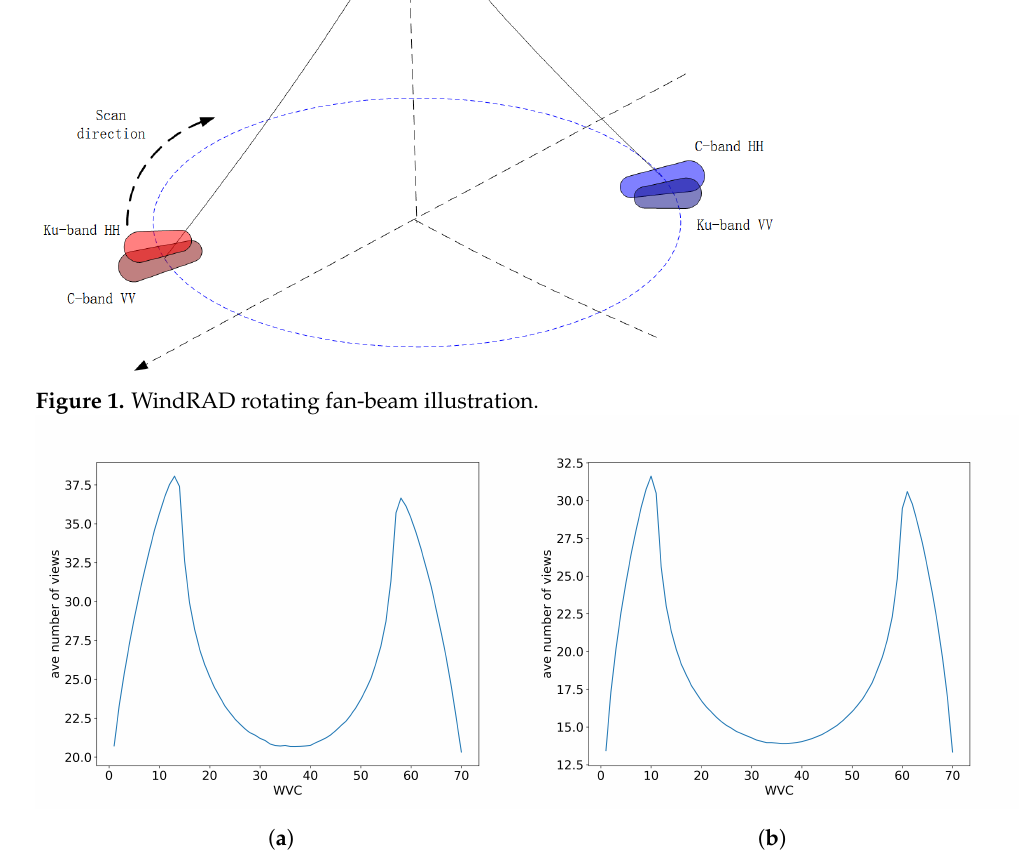
Figure 2. Average number of views as a function of WVC: ( a ) C-band HH and VV beams. ( b ) Ku-band HH and VV beams.